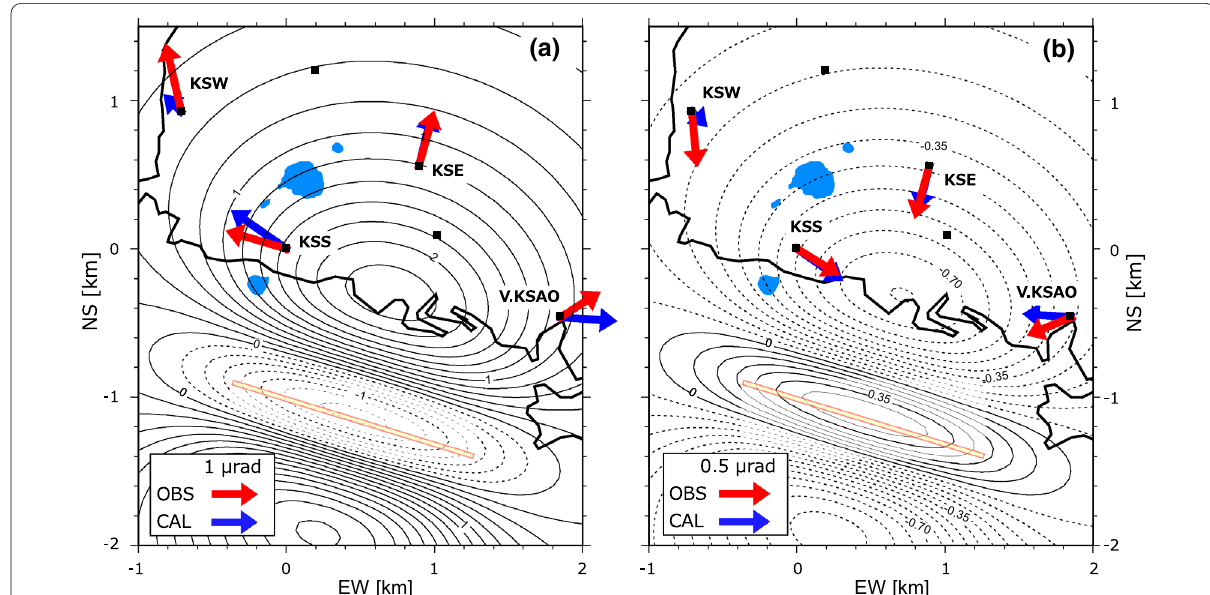
Fig. 10 Comparison of observed (red arrows) and modeled (blue arrows) tilt vectors on 27 May 2011. a Inflation phase and b deflation phase. The location of the modeled crack is represented by the yellow rectangle. Modeled vertical displacement is projected onto a virtual plane at 2100 m asl (corresponding to an altitude of MC) at intervals of 0.2 mm and 0.07 mm, respectively. Solid and dashed contour lines correspond to vertical uplift and subsidence, respectively. Crack parameters such as X, Y, Z, L, A, and D are the same as for Fig.